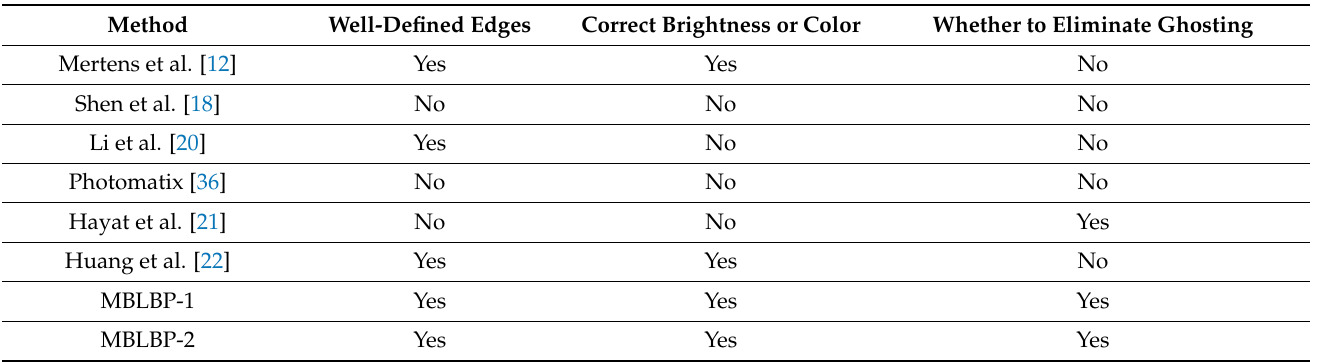
Table 5. Detailed comparison of Figure 8.